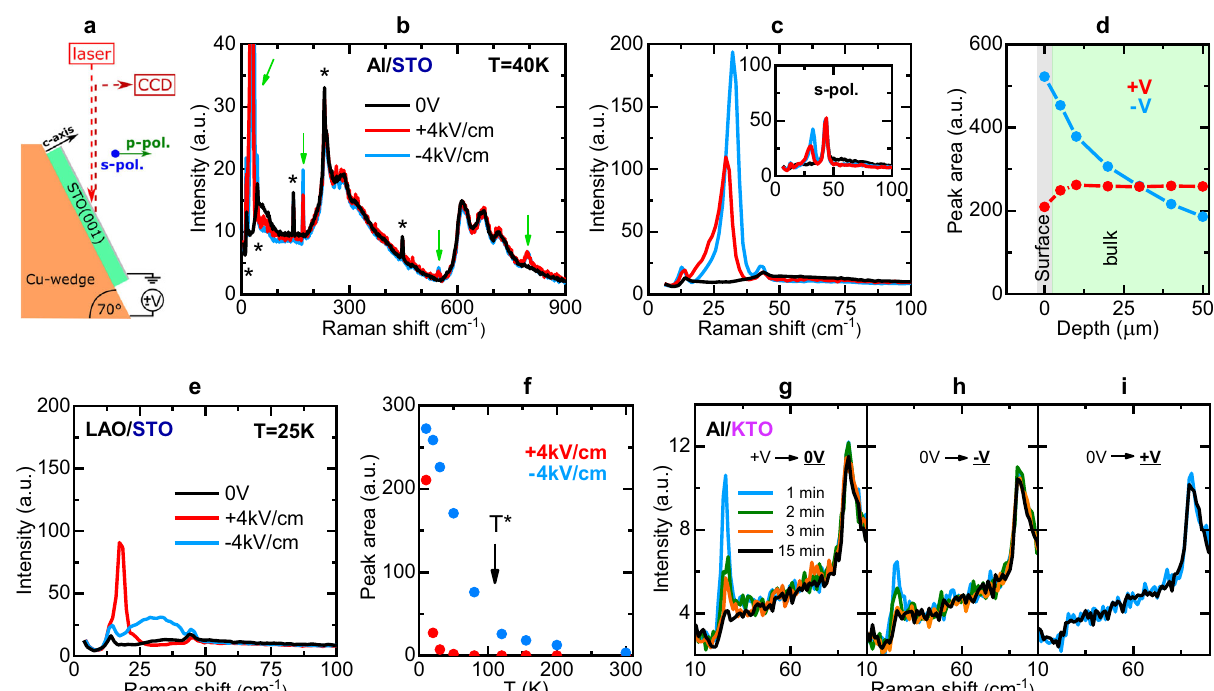
Fig. 3 Confocal Raman spectroscopy study of the induced polar moment. a Sketch of the measurement geometry. b Gate-voltage-dependent spectra of an AlO x /SrTiO 3 heterostructure at 10 K. A Stokes/Anti-Stokes comparison yields a temperature offset of max. ∼ 20 K, caused by laser heating. Black stars mark the R-modes at 15, 45, 144, 229 and 447 cm − 1 that become Raman-active below the antiferrodistortive transition temperature T* = 105 K. Green arrows show the fi eld-induced infrared-active phonon modes at 25, 175, 540 and 795 cm − 1 . c Magni fi ed view of the fi eld-induced soft mode (TO 1 ) and its asymmetry with respect to ±V. Inset: Corresponding spectra taking in s-polarization (normalized to the multi-phonon background). d Depth pro fi le of the normalized peak area of the soft mode for + V and − V. e Field-dependence of the soft mode of a LaAlO 3 /SrTiO 3 heterostructure. f Temperature dependence of the peak area of the soft mode for + V and − V. g – i Low-frequency Raman spectra of an AlO x /KTaO 3 (KTO) heterostructure, showing a weak and rapidly decaying (within minutes) soft mode signal that occurs only after the voltage has been decreased, i.e. either from + V to 0 V ( g ) or from 0 V to − V ( h ), but is absent after a corresponding voltage increase from 0 V to + V or from − V to 0 V ( i